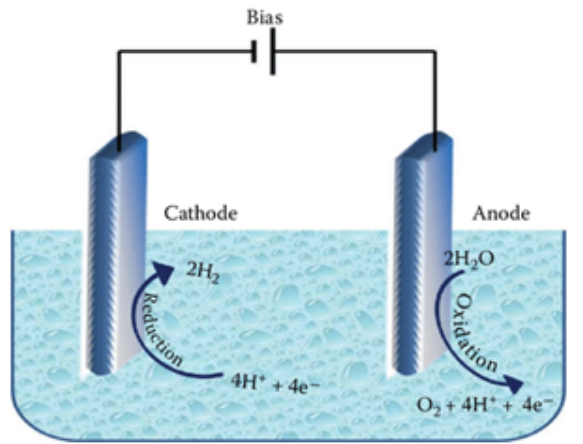
Figure 28. Schematic illustration of the experimental setup of electrochemical water splitting. Fujishima and Honda first described the photoelectrochemical cell (PEC) splitting of water using a crystalline titanium dioxide anode and a platinum cathode under ultraviolet (UV) irradiation and an external bias [24,135]. The anodic and cathodic reactions are as indicated below [136].